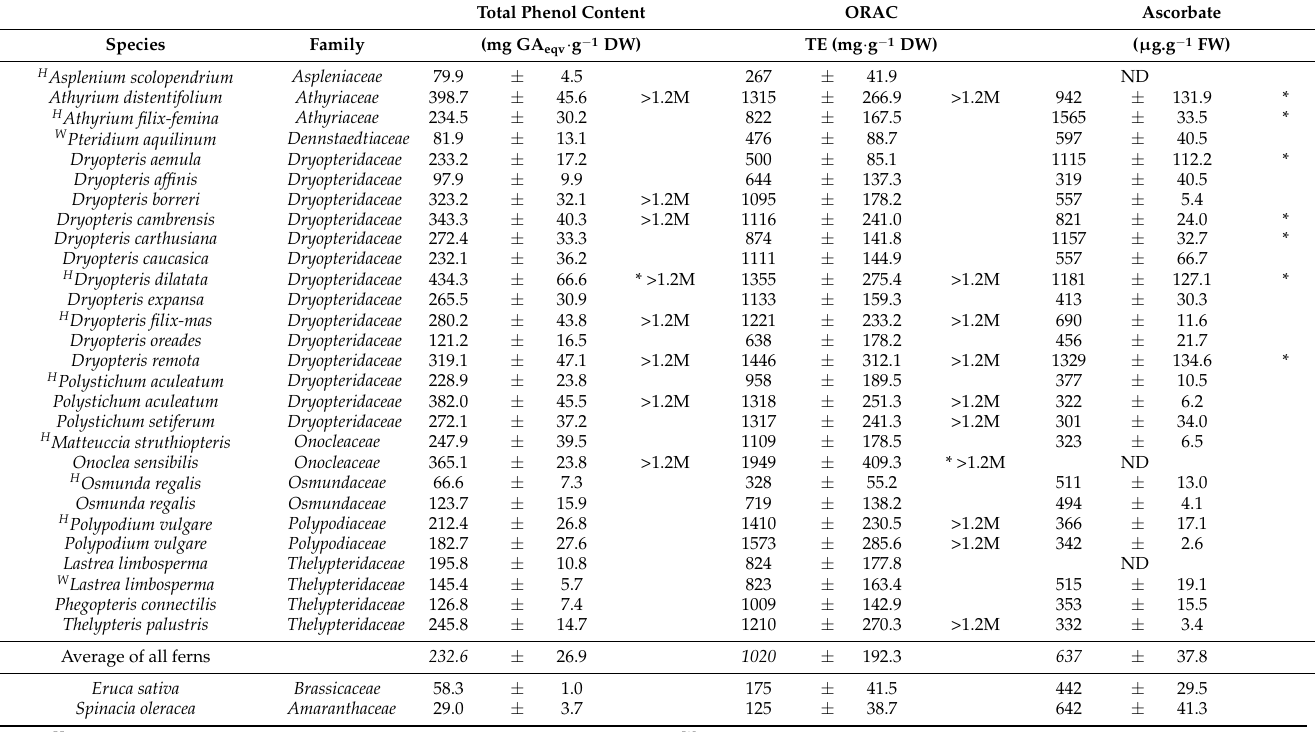
Table 1. The content of antioxidants and antioxidant capacity in fern